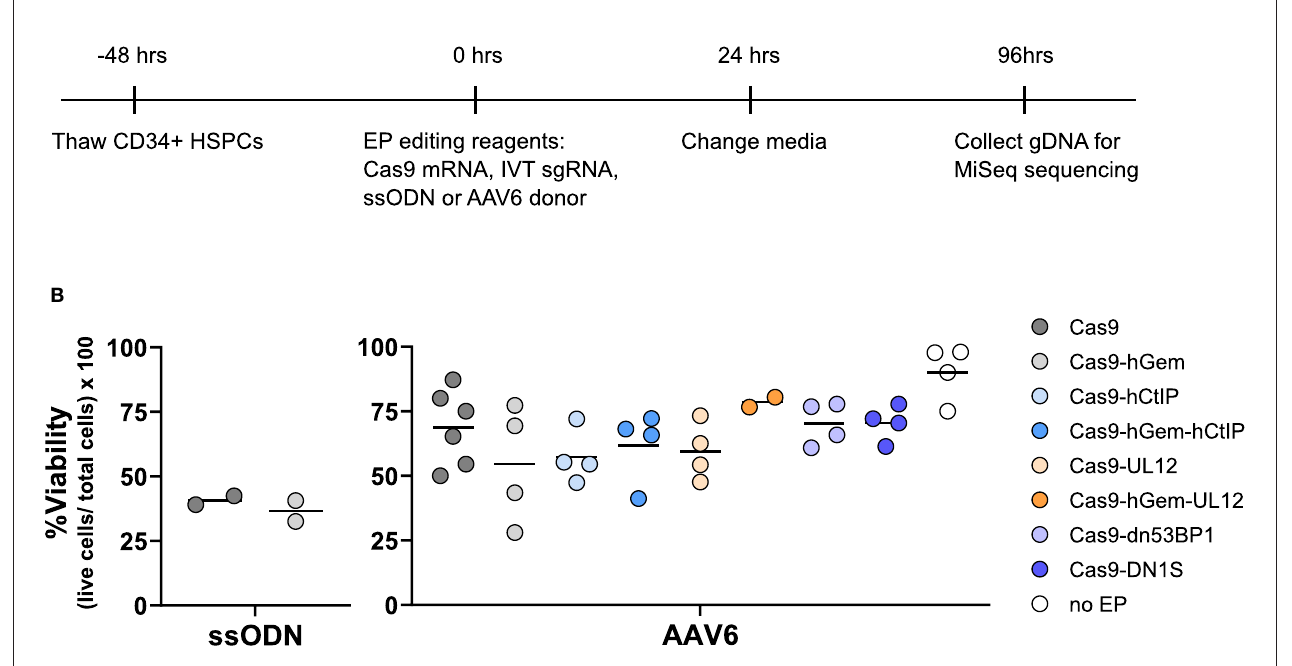
FIGURE 5 | Experimental outline of Cas9 variant gene editing in HSPCs. (A) Experimental overview of electroporation of Cas9 variants delivered as IVT mRNA to CD34 + HSPCs. Cas9 variants were electroporated at equimolar amounts (3 pmol) with 120 pmol of IVT sgRNA targeting the SCD mutation at the HBB locus, and either a ssODN (3 µ M) or AAV6 donor (MOI 2e4). Editing outcomes were measured by MiSeq HTS 4 days post-electroporation. (B) Viability of CD34 + HSPCs edited with Cas9 variants, and an ssODN or AAV6 donor 24h post-electroporation. n = 2–6 biological replicates. Center line represents mean. Differences are not